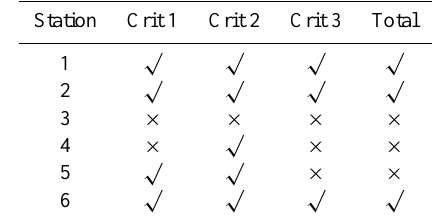
Table 1. Decisions of the station selection algorithm for the six sta- tions in Fig. 2. The columns labeled with Crit 1, Crit 2, and Crit 3 refer to the three criteria listed in Sect. 2.2 (absolute height h , dif- ference 1h between the absolute height h and the height of the min- imum topography h MT , and the ratio r of the vertical and the hori- zontal distance between two stations). Accepted stations are marked √ by the symbol and discarded stations by the ×